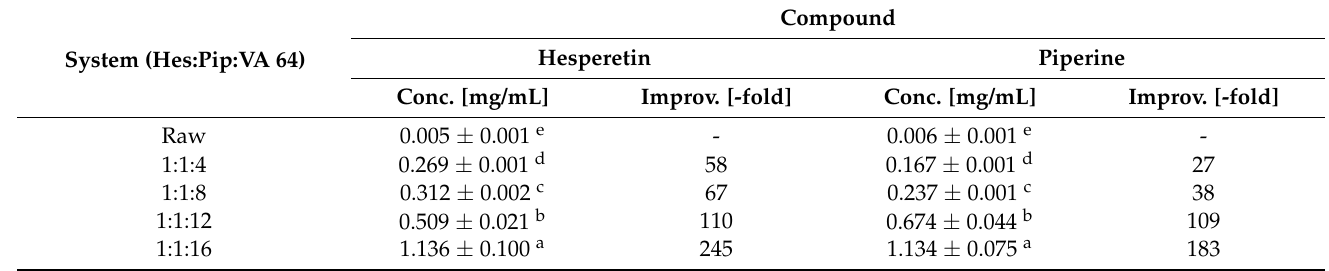
Table 1. The results of solubility studies of amorphous systems are presented as achieved concentra- tions and folds of improvement with regards to hesperetin and